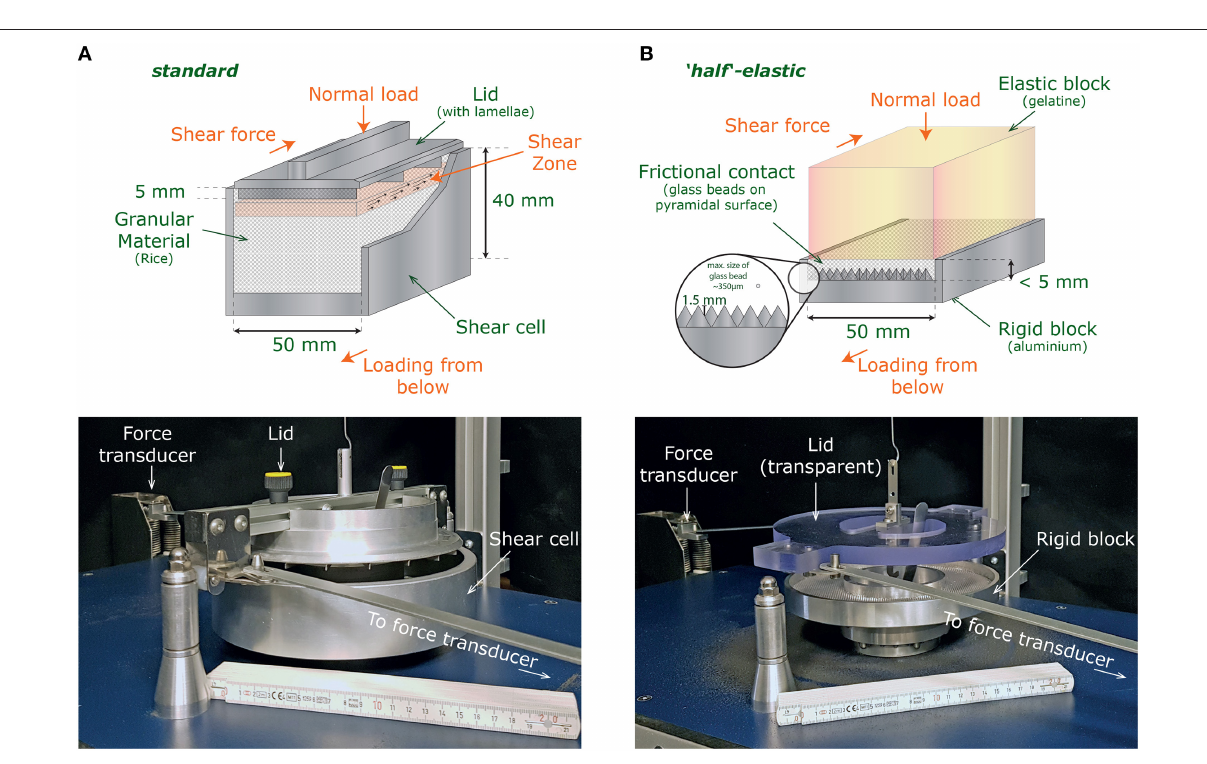
algorithm (Rosenau et al., 2009, 2017). A solid, aluminum lid, with lamellae providing a high friction interface, is placed on top of the rice. The upper surface of the lid is covered with a white- on-black random pattern of dots, which is ideal for the later digital image correlation (section 2.2). Because the lid is rigid,